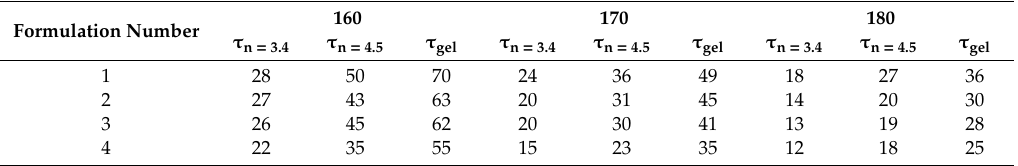
Table 5. The characteristic times of the process of structuring at di ff erent temperatures for the studied formulations, obtained using di ff erent approaches in the analysis of viscosimetric